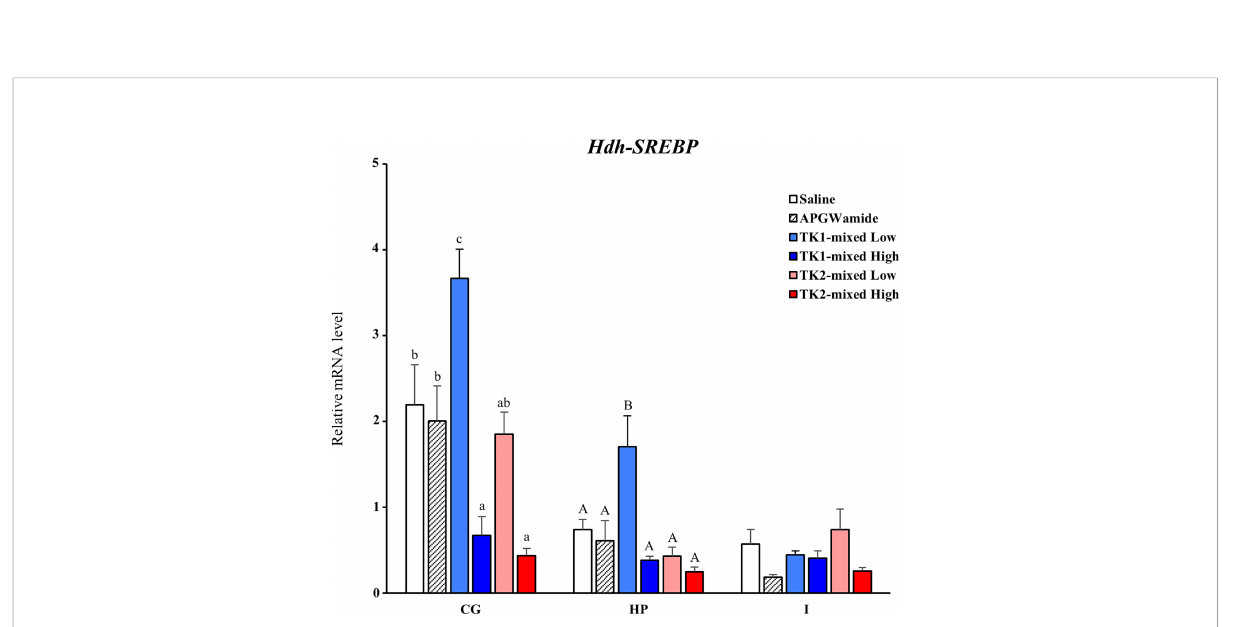
FIGURE 11 Effect of Hdh-TK peptides on relative transcript levels of Hdh-SREBP in abalone. At 24 h after injection of Hdh-TK1 and TK-2 peptide mixtures (low dose, 0.25 m g/g BW; high dose, 2.5 m g/g BW) along with an equal volume of saline and APGWamide (2.5 m g/g BW), the tissues of abalone were sampled. The relative Hdh-SREBP transcript levels were measured by real-time quantitative PCR. The ribosomal protein L-5 ( Hdh-RPL5 ) was used as the internal control. All data represent the mean ± SEM (n = 8). Different upper and lower case letters on the bars indicate statistically signi fi cant differences (p < 0.05). CG, cerebral ganglion; HP, hepatopancreas; I, intestine.